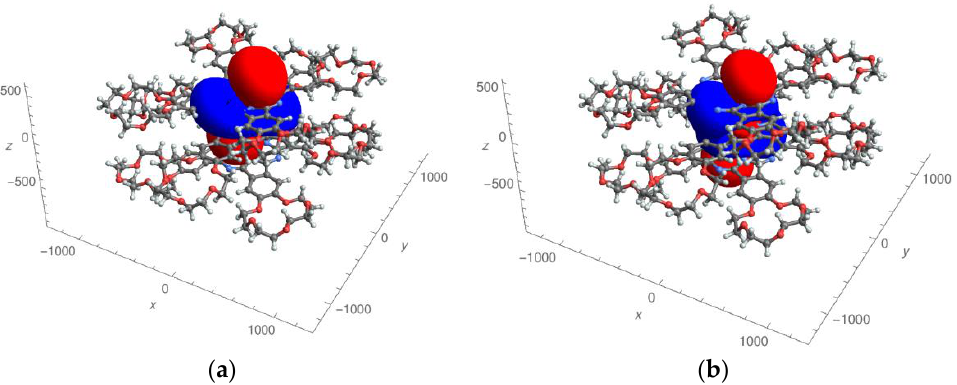
Figure 3. Effective field of the pseudo-contact contributions to lanthanide-induced shifts in the Dy complex created by only one lanthanide cation ( a ) and two lanthanide cations ( b ). Areas with positive shift values are shown in red, and areas with negative shift values are shown in blue.